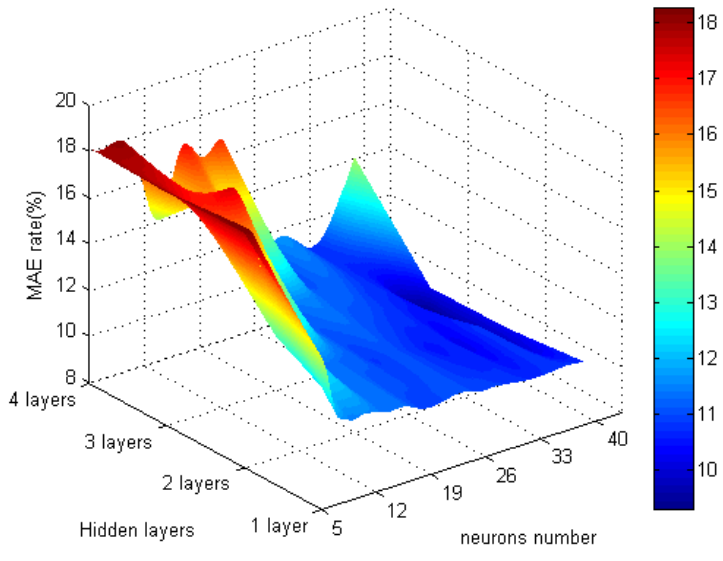
Fig. 1. The MAE of the neural networks with different hidden layers and neurons